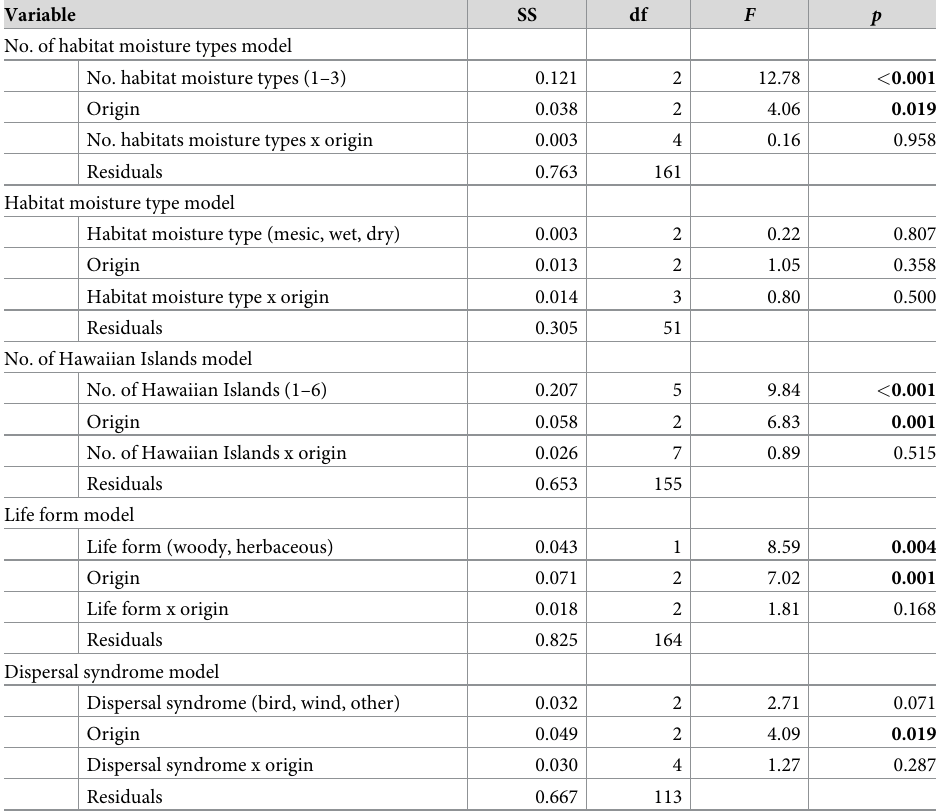
Table 5. Two-way ANOVA’s. Conducted for each categorical variable (number of habitat moisture types, habitat moisture type, number of main Hawaiian Islands, life form, dispersal syndrome) to determine if habitat specialization rankings (Jaccard index) differed among categories while controlling for biogeographic